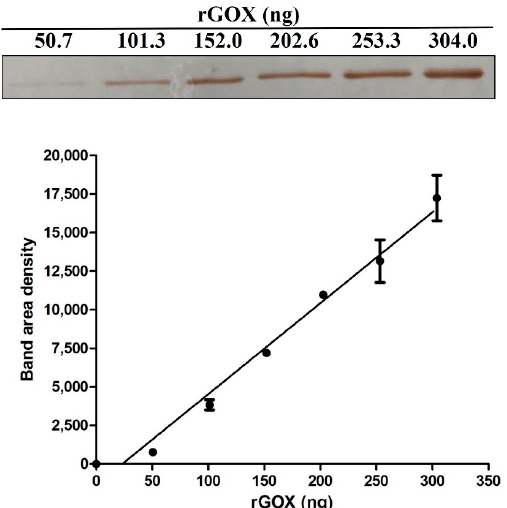
Figure 4. Quantitative profile of recombinant glucose oxidase (rGOX) on immunoblot used for GOX quantification in honeys. rGOX was prepared by a heterologous expression in Escherichia coli . Specific immunoreactive bands on membrane were quantified by densitometry using ImageJ software (NIH, USA). The graph shows good correlation between increasing amounts of rGOX and densitometry signals on the created calibration curve.